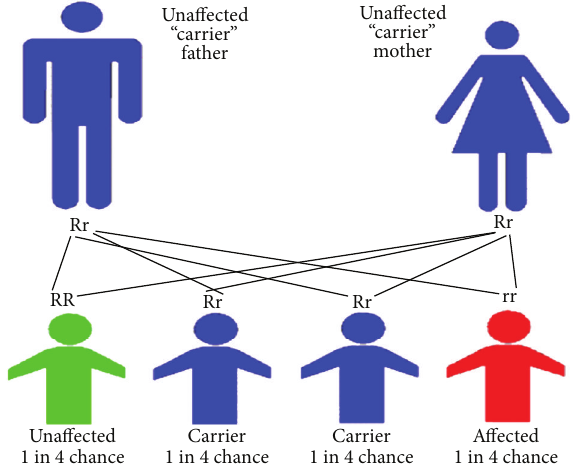
Figure 1: Sickle cell disorder inheritance pattern.